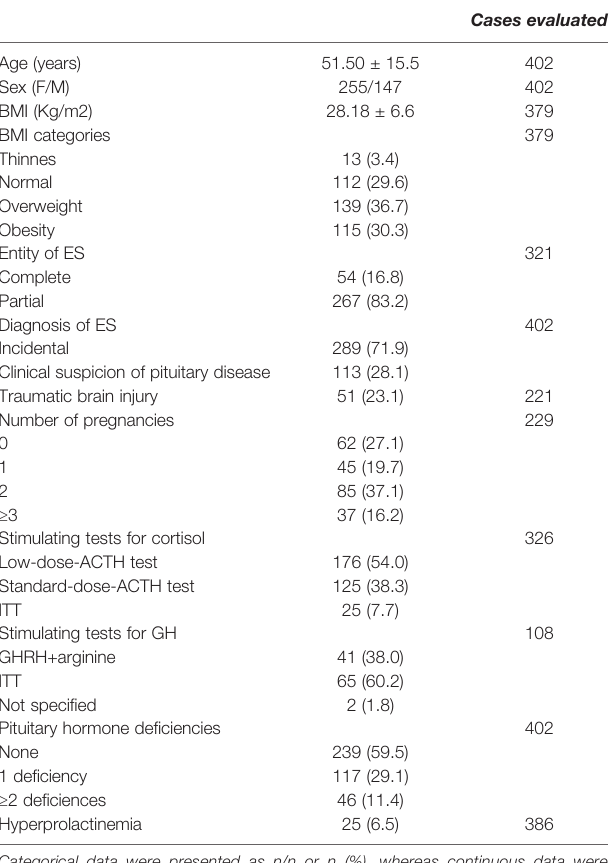
TABLE 1 | Demographical and clinical features of 402 subjects with empty sella at the study entry.